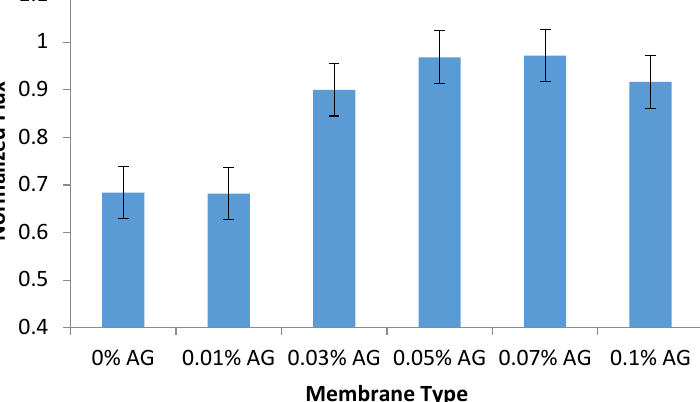
Figure 8. Normalized flux of PA/AG membranes (at different AG loadings in dope) after filtration of 100 ppm sodium alginate solution at an operating pressure of 15 bars for 2 h. pH: 6.95.